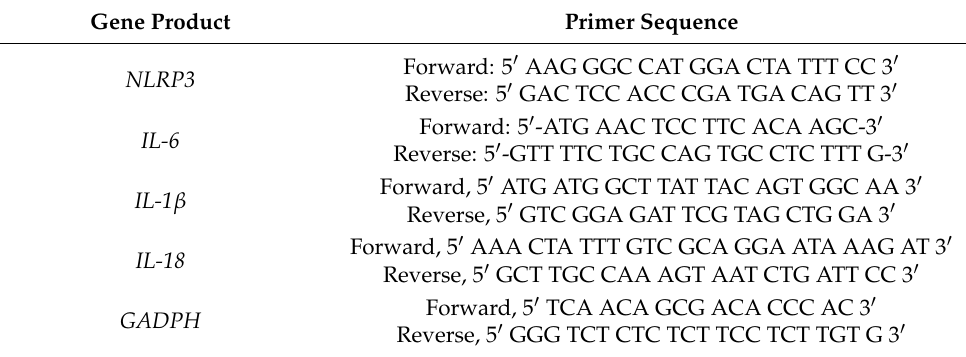
Table 1. Primer sequences used in this study for determination of gene expressions by RT-qPCR analysis